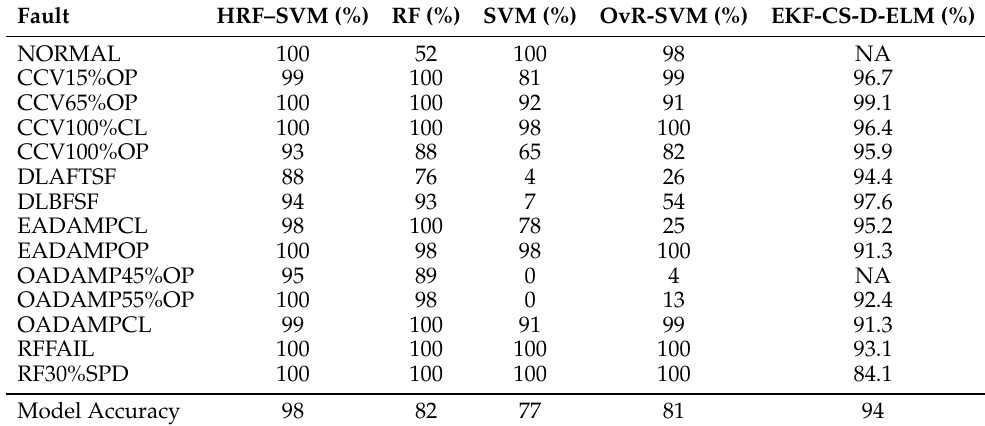
Table 3. Comparison results for fault detection and diagnosis of HVAC